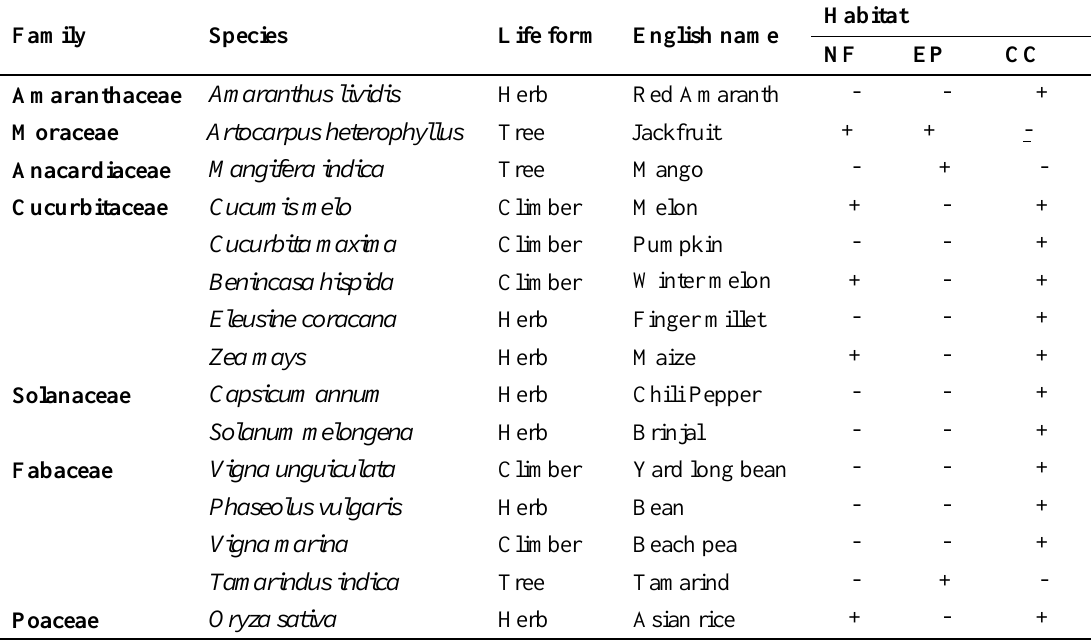
Table 1 : List of cultivated plant seeds which were dispersed by the elephants in the study area.